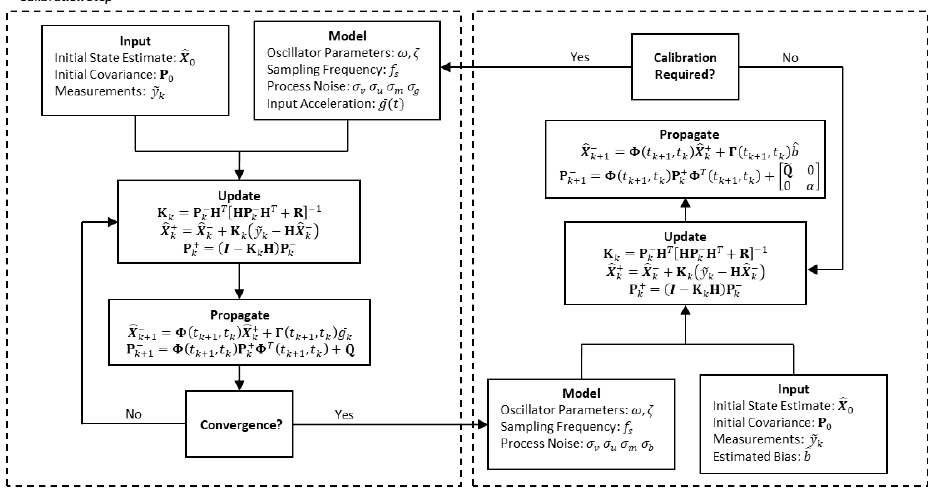
Figure 1. Flowchart of the calibration and operation Kalman filters. As shown, the outputs of each filter are provided as inputs to the other. Equation (20) can easily be substituted into the calibration step to use the lerast squares solution in place of the Kalman filter.